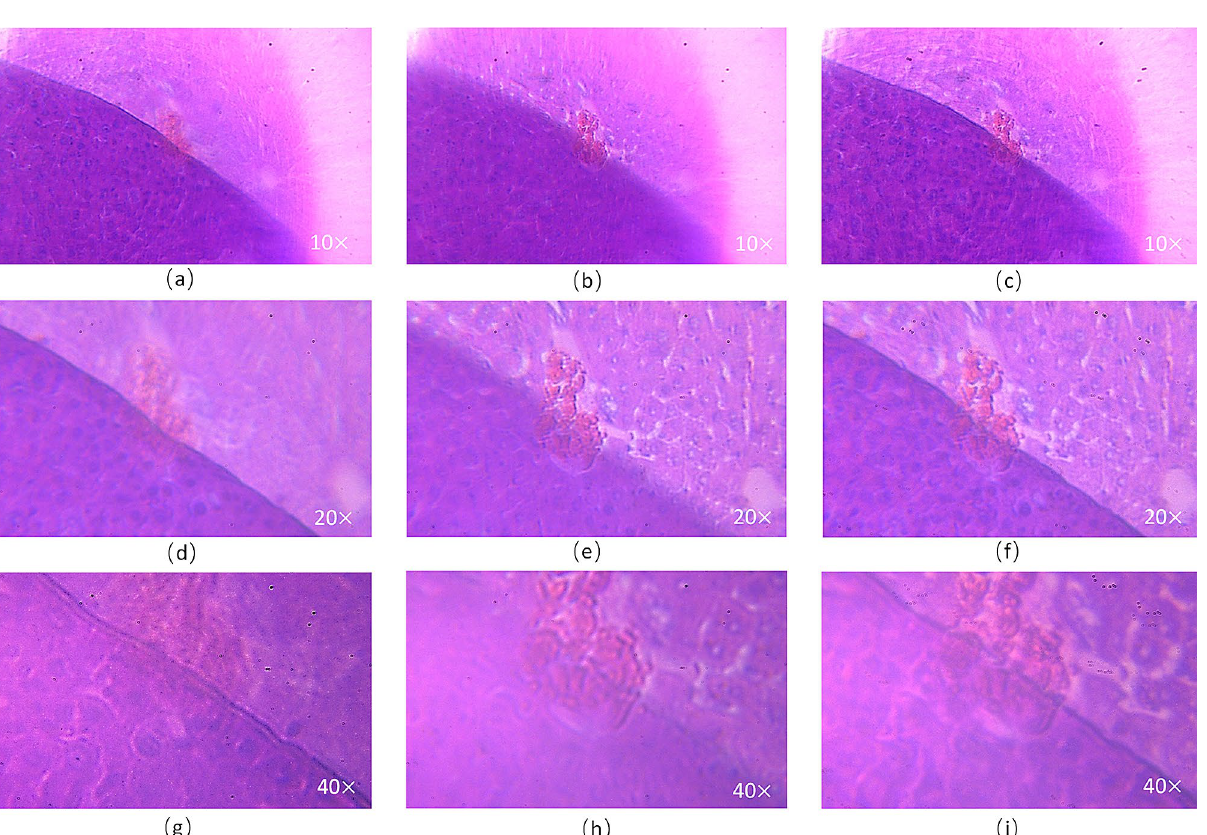
Figure 10. EDOF microscopic images of the mouse lung slices and composite EDOF image at different magnifications. ( a ) Image with 10× objective focused at near distance. ( b ) Image with 10× objective focused at far distance. ( c ) EDOF image at 10×. ( d ) Image with 20× objective focused at near distance. ( e ) Image with 20× objective focused at far distance. ( f ) EDOF image at 20×. ( g ) Image with 40× objective focused at near distance. ( h ) Image with 40× objective focused at far distance. ( i ) EDOF image at